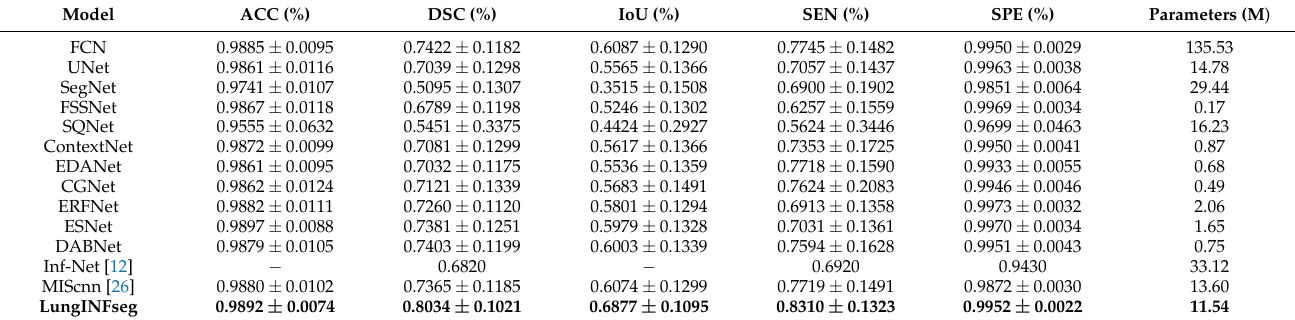
Table 6. Comparing the proposed model with 13 state-of-the-art baseline segmentation methods on the test set (mean ± standard deviation). Best results are in bold. Dashes-indicate that the information is not reported in the cited references.